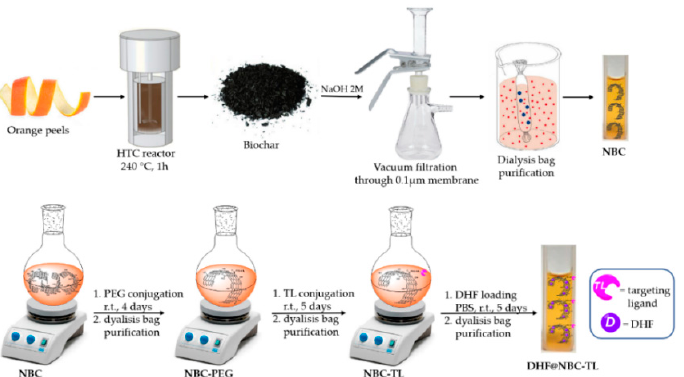
Figure 2. Schematic representation of methodology employed for the preparation of NBC-based DDS.